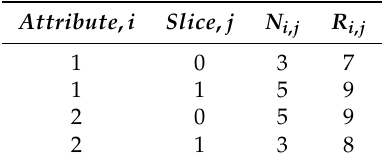
Table 3. Bit-slice length, N and maximum bit-length, R recommended by DataNode 1 . Attribute , i